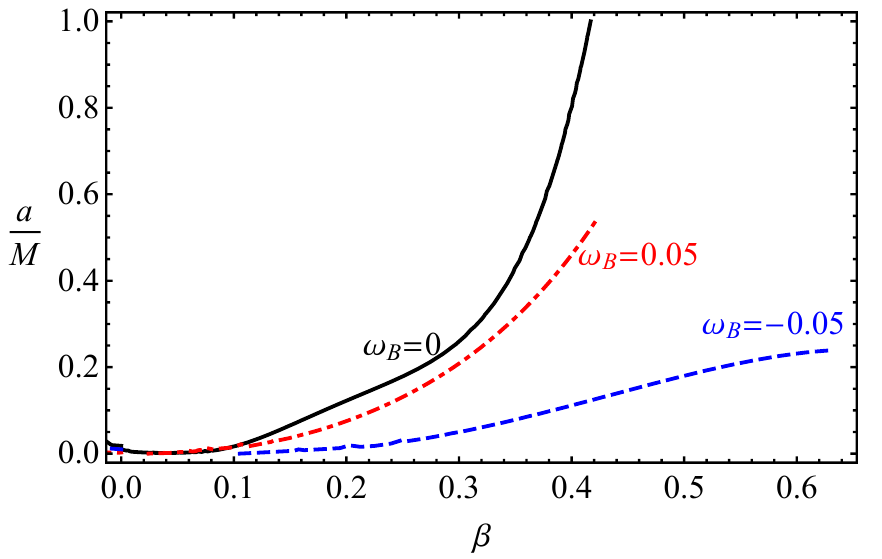
Figure 6. Degeneracy between parameter β and a , i.e., for a given value of β there exists a Kerr geometry with a given value of spin parameter a / M that has the same ISCO radius for various combinations of parameter ω B . The point to be noted here is that a / M represents a black hole rotation (spin) parameter.